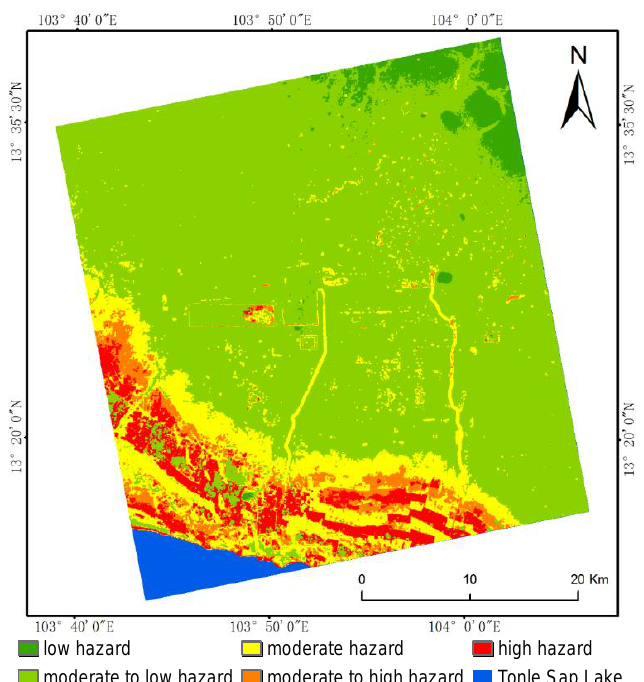
Figure 7. Flood hazard assessment map of Angkor.